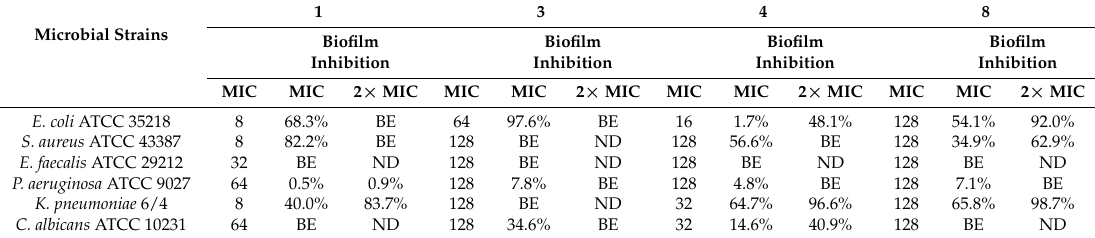
Table 2. Biofilm formation inhibition exerted by compounds 1 , 3 , 4 , and 8 . Each molecule was added at its relative MIC and 2 × MIC ( µ g/mL) values during the biofilm formation of the different pathogens; the inhibition percentages were determined after spectrophotometer reader at 570